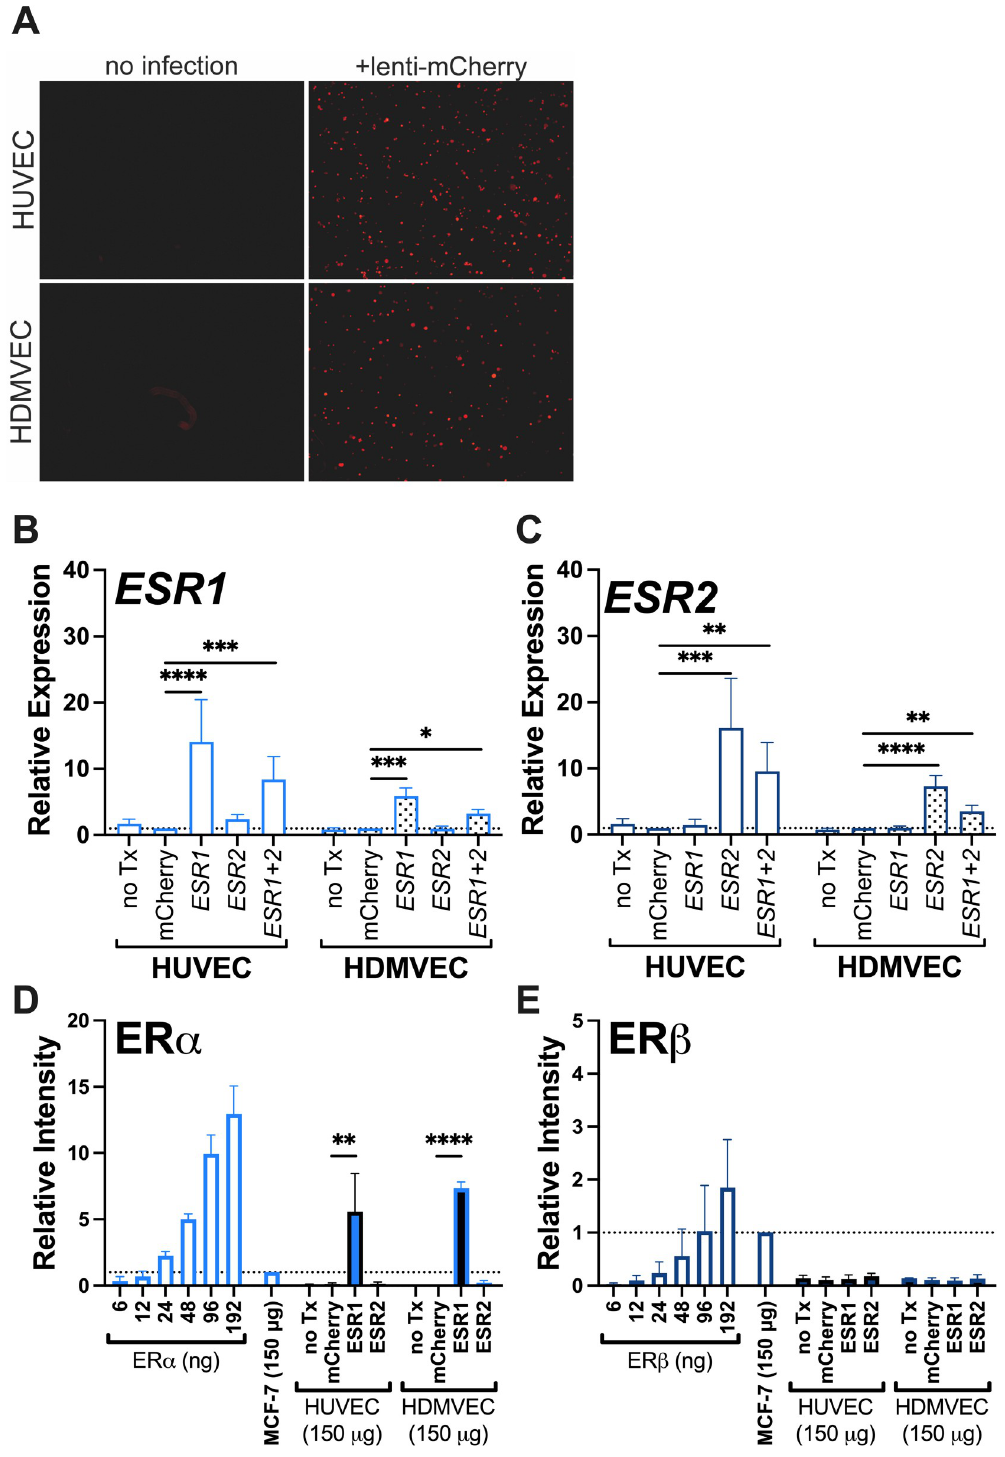
Fig 4. Lentiviral-mediated overexpression of ESR1 and ESR2 . (A) HUVEC and HDMVEC tolerance of lentiviral transduction was measured by fluorescence 72 hours after lenti-mCherry transduction. (B) ESR1 and (C) ESR2 expression was measured by RT-qPCR and normalized to lenti-mCherry samples (N = 4). Relative expression of (D) ER α and (E) ER β protein in HUVEC and HDMVEC following lentiviral transduction was normalized using MCF-7 immuno-dot blot intensity (N = 3). Bars = mean + SEM; * p < 0.05, ** p < 0.01, *** p < 0.001, **** p < 0.0001.